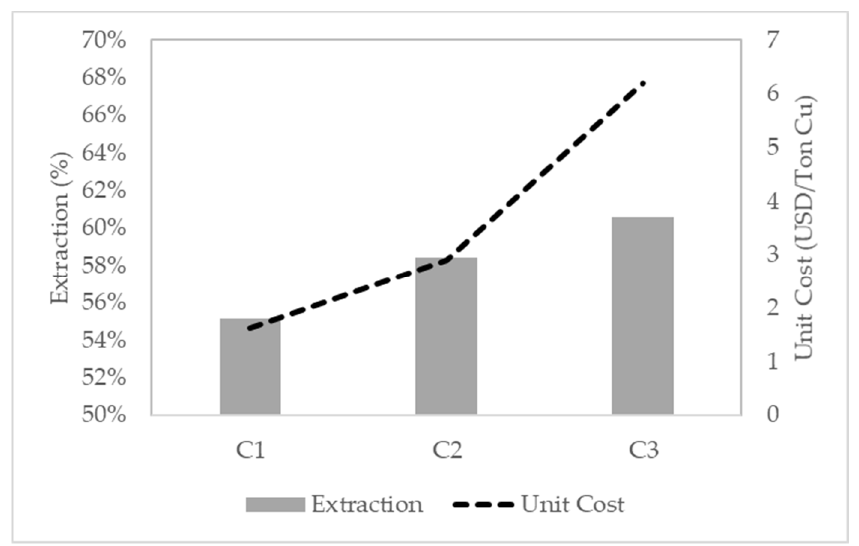
Figure 7. Comparison of the extraction percentage and unit cost as a function of the reagents added.